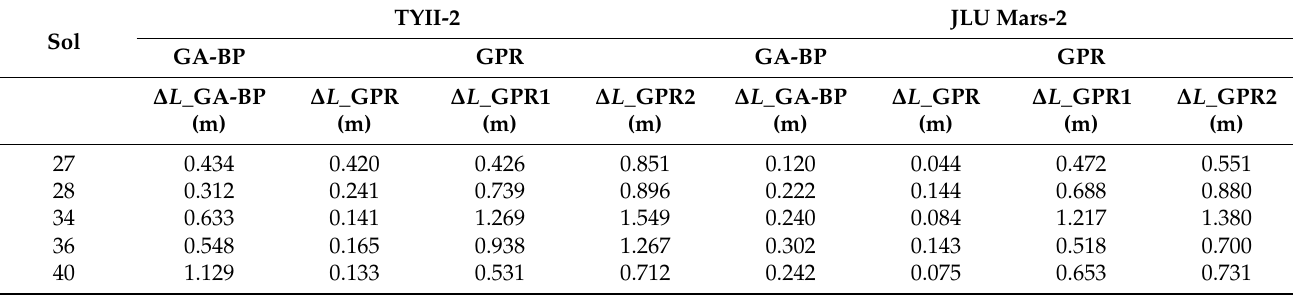
Table 7. ∆ L _GA-BP and ∆ L